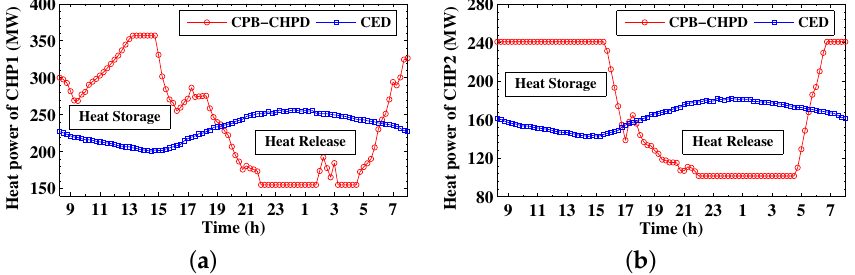
Figure 7. Heat power output of the CHP units at each period in Case 1: ( a ) the first CHP unit CHP1; ( b ) the second CHP unit CHP2.